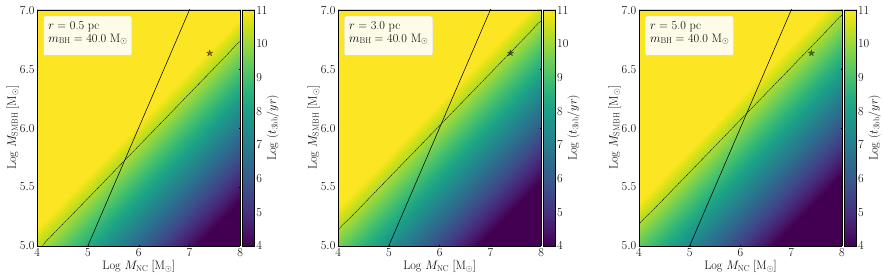
Figure 9. Three-body timescale as a function of the NC (x-axis) and SMBH (y-axis) mass. We assumed three equal-mass BHs ( m BH = 40 M ) orbiting at r = 0.5–0.3–5 pc from the SMBH (from left to (cid:12) right, respectively). The star marks typical values in the Milky Way. The straight line marks the case M NC = M SMBH, whilst the dotted line separates the region with a t 3bb smaller (below the line) or larger (above the line) than the Hubble